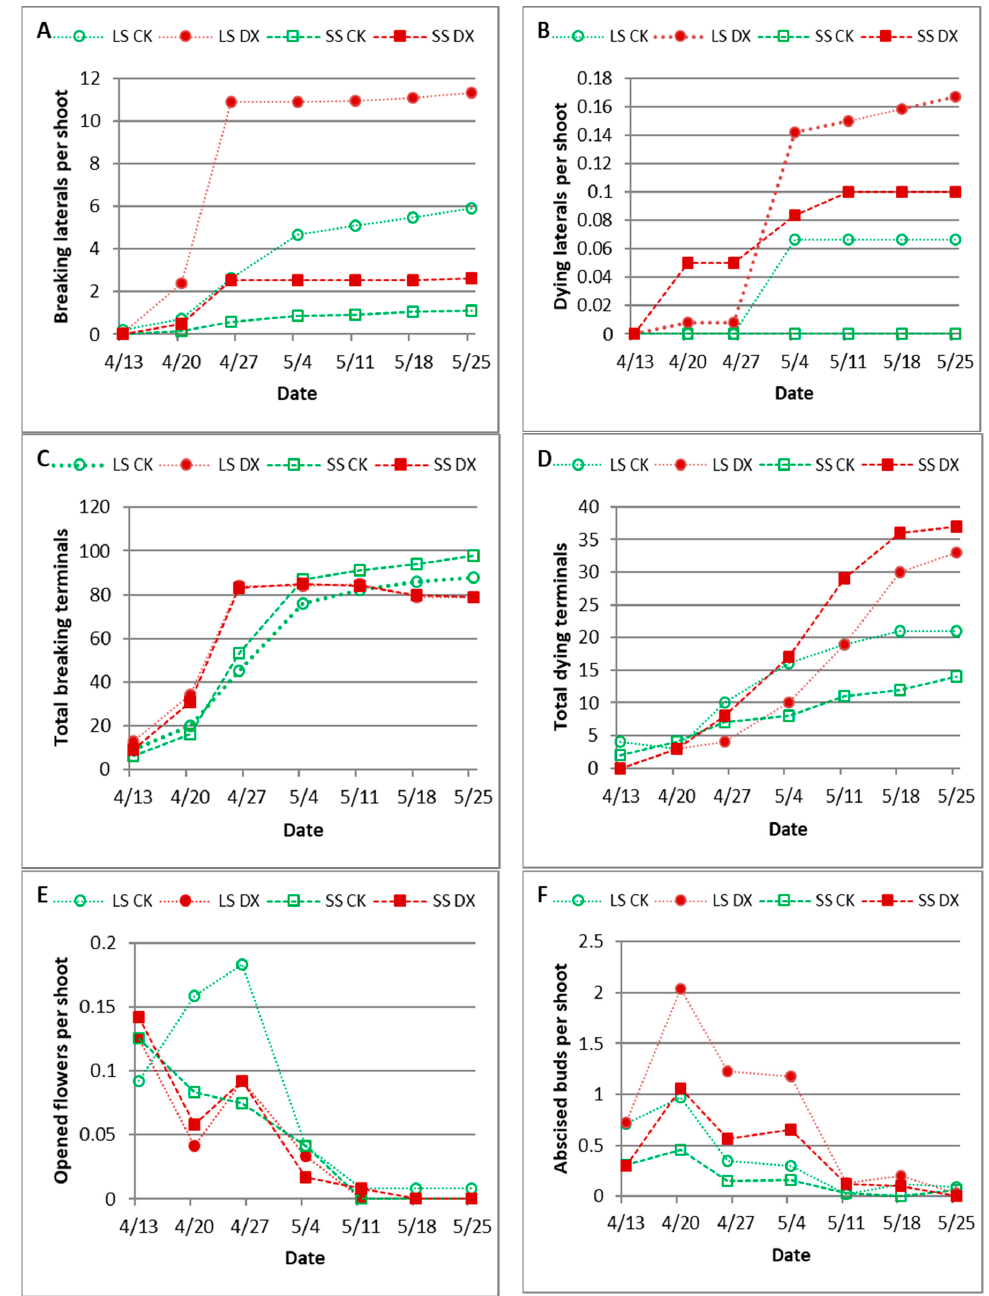
Figure 1. Averages of counts from all cultivars on the seven sampling days. Cumulative breaking laterals per shoot ( A ), cumulative breaking but dying laterals per shoot ( B ), total breaking terminals of all shoots ( C ), total breaking but dying terminals of all shoots ( D ), weekly opened flowers per shoot ( E ), and weekly abscised buds per shoot ( F ). Nearly zero breaking lateral bud ( A ) or opened flower ( E ) was observed on Apr 13, 2017 (4/13 on the x axis) when Dormex was sprayed. LS—long shoot; SS—short shoot; CK—unsprayed control; DX—Dormex sprayed. Table 1. Statistical analysis of bud counts on 4/13 (unopened) and 5/25 (breaking) and their respective ratios z .